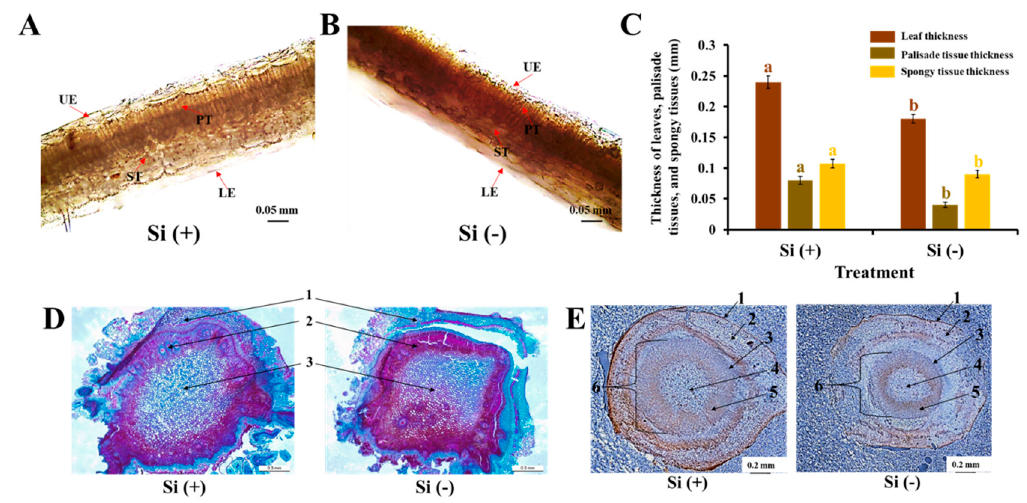
Figure 4. Effect of 30 days of silicon application on anatomical features of leaves, stems, and roots in the coffee plants grown in plant growth chambers. Leaf structure ( A , B ) and column diagram of leaf structures ( C ); UE, upper epidermis; LE, lower epidermis; PT, palisade tissues; ST, spongy tis- sues; bars indicate 0.05 mm. Stem structure ( D ); 1, 2, and 3 refer to the cortex, vascular bundle, and pith, respectively; bars indicate 0.3 mm. Root structure ( E ); 1, 2, 3, 4, 5, and 6 refer to the epidermis, cortex, pericycle, xylem, phloem, and stele, respectively; bars indicate 0.2 mm. Si (+) and Si ( − ) refer to 75 and 0 mg·L − 1 , respectively. Vertical bars indicate the means ± standard error ( n = 6). Different lowercase letters indicate the significant separation within treatments by the Duncan’s multiple range test at p ≤ 0.05. Figure 5. Effect of 30 days of silicon application on stomatal characteristics in the coffee plants grown in plant growth chambers. Stomatal density ( A , B ), 20 times amplification. Stomatal morphology ( C , D ), 40 times amplification. Si (+) and Si (-) refer to 75 and 0 mg·L − 1 , respectively. Vertical bars indicate the means ± standard error ( n = 6). Different lowercase letters indicate the significant sepa- ration within treatments by the Duncan’s multiple range test at p ≤ 0.05. Bars indicate 10 μ m. 2.4. Chlorophyll Content, Photosynthesis, and Chlorophyll Fluorescence Characteristics One of the most important factors for photosynthetic activity is the photosynthetic pigment. The contents and ratios of chlorophyll are given in (Figure 6). Applying silicon increased the chlorophyll content in coffee leaves. The results show a dramatic increase in the content of chlorophyll a, chlorophyll b, and chlorophyll a + b in the Si-treated leaves